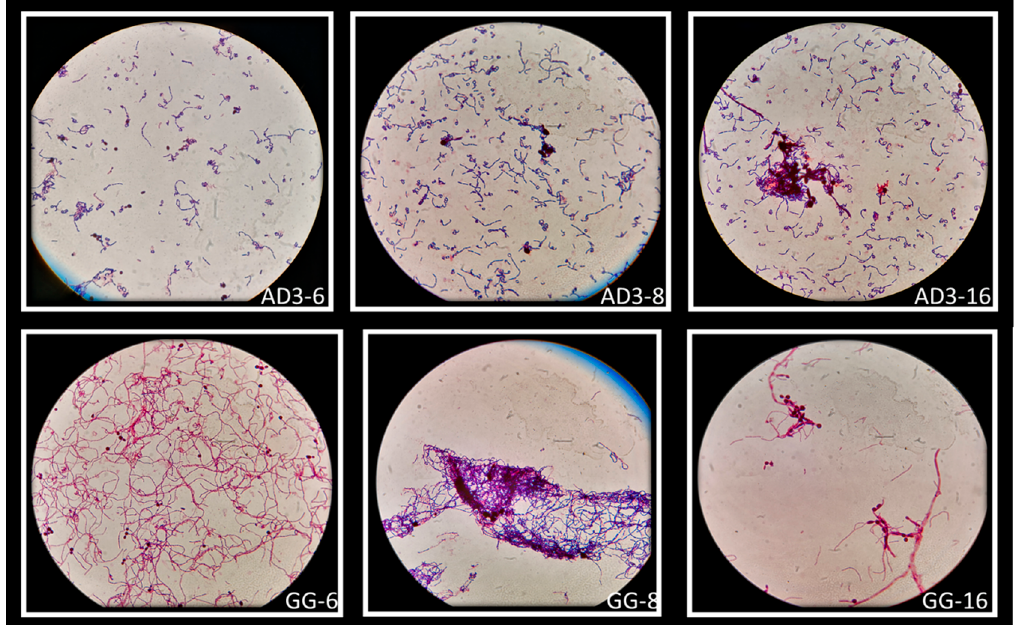
Figure 7. Macroscopically visible clumps after Giemsa staining of L. rhamnosus AD3 and GG with all three Candida strains. Co ‐ aggregates of L. rhamnosus AD3 with C. albicans (AD3 ‐ 6), C. krusei (AD3 ‐ 8) and C. tropicalis (AD3 ‐ 16). Co ‐ aggregates of L. rhamnosus GG with C. albicans (GG ‐ 6), C. krusei (GG ‐ 8) and C. tropicalis (GG ‐ 16).